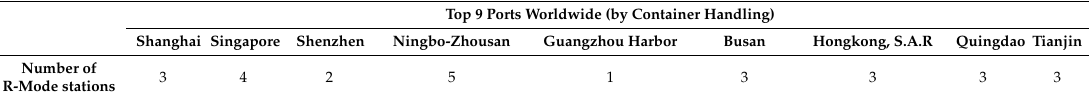
Table 1. Top nine container ports and their respective potential R-Mode coverage